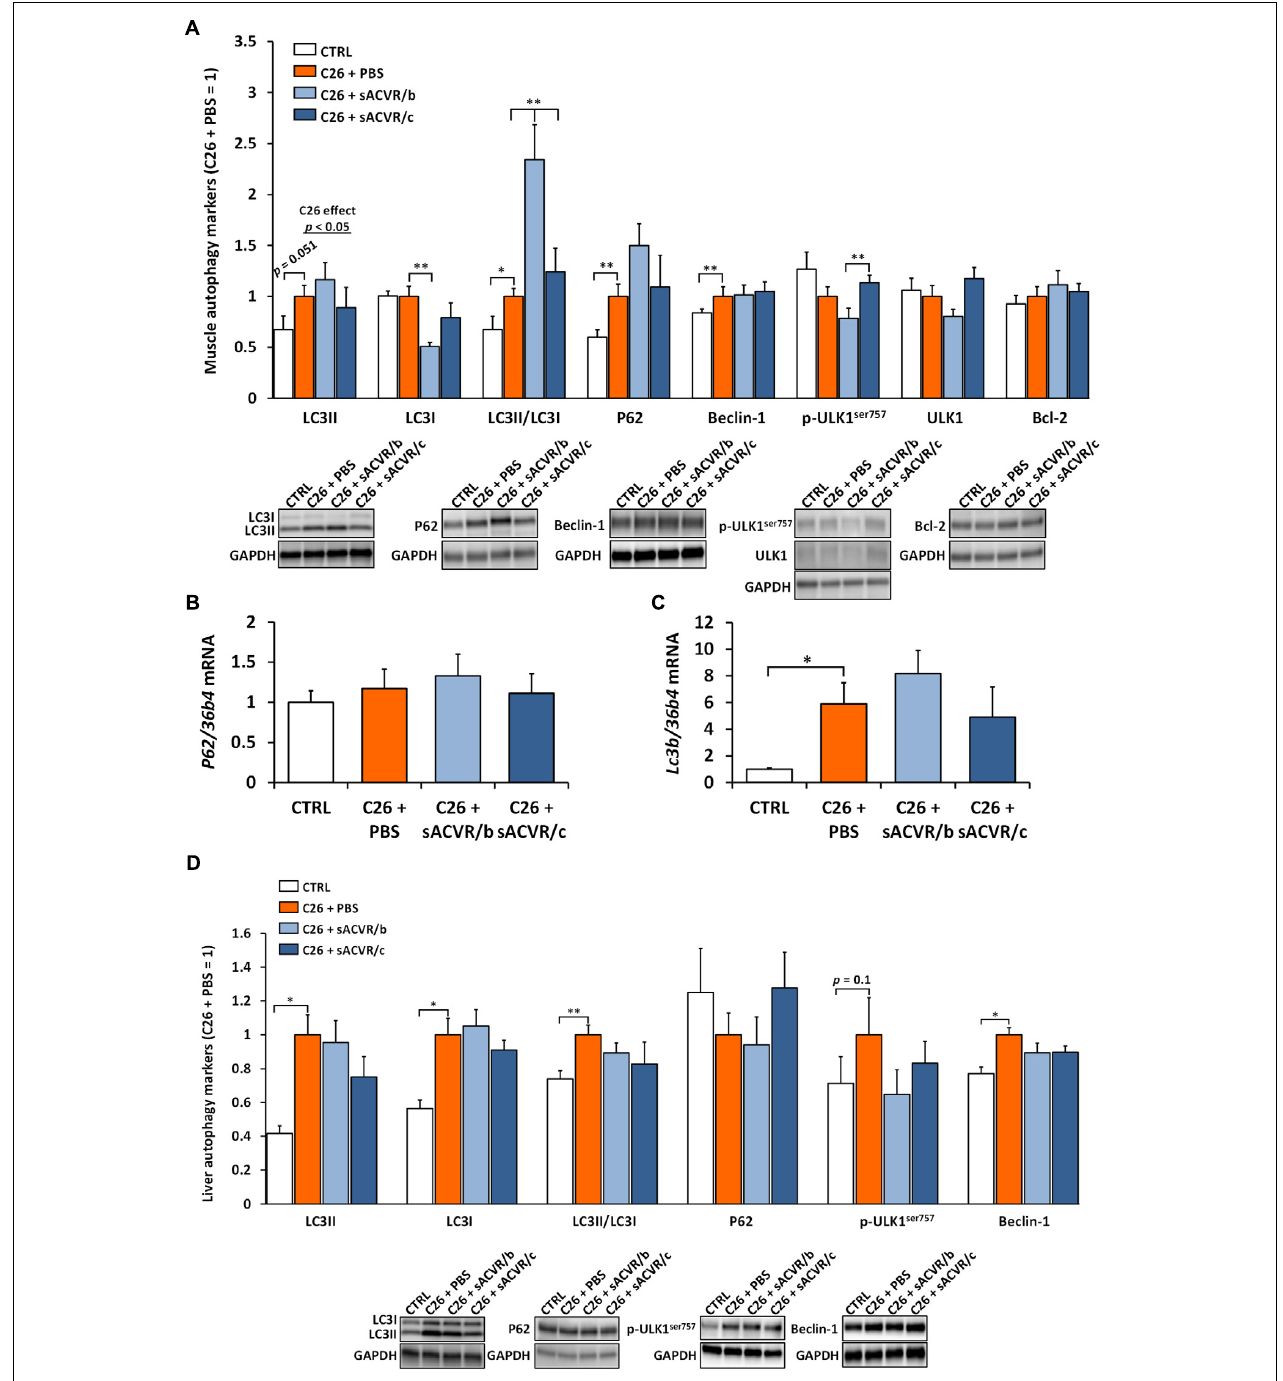
FIGURE 8 | Autophagy markers in skeletal muscle and the liver of C26 tumor-bearing mice. (A) Protein content of autophagy markers in skeletal muscle (LC3II, LC3I, LC3II/LC3I, P62, Beclin-1, p-ULK1 ser757 , total ULK1, and Bcl-2). The mRNA level of (B) P62 and (C) Lc3b in skeletal muscle. (D) Protein content of autophagy markers in the liver (LC3II, LC3I, LC3II/LC3I, P62, p-ULK1 ser757 , and Beclin-1). CTRL, vehicle-treated (PBS) healthy control mice, n = 7–9. C26 + PBS = C26 tumor-bearing mice administered with a vehicle (PBS), n = 7. C26 + sACVR/b = C26 tumor-bearing mice administered with sACVR before the tumor formation and replaced by a vehicle (PBS) after the tumor formation, n = 7. C26 + sACVR/c = C26 tumor-bearing mice continuously administered with sACVR throughout the experiment, n = 8. The symbol ∗ depicts statistical significance p < 0.05 and the symbol ∗∗ depicts statistical significance p < 0.01. For the C26 effect, tumor-bearing groups were pooled. Data is expressed as means ± SE. Representative blots were cropped from the original blot images ( Supplementary Figures 9, 11 , 12 ). Representative blots with same IDs and analyzed in the same run are aligned on top of each other and share the same representative control blot (GAPDH).